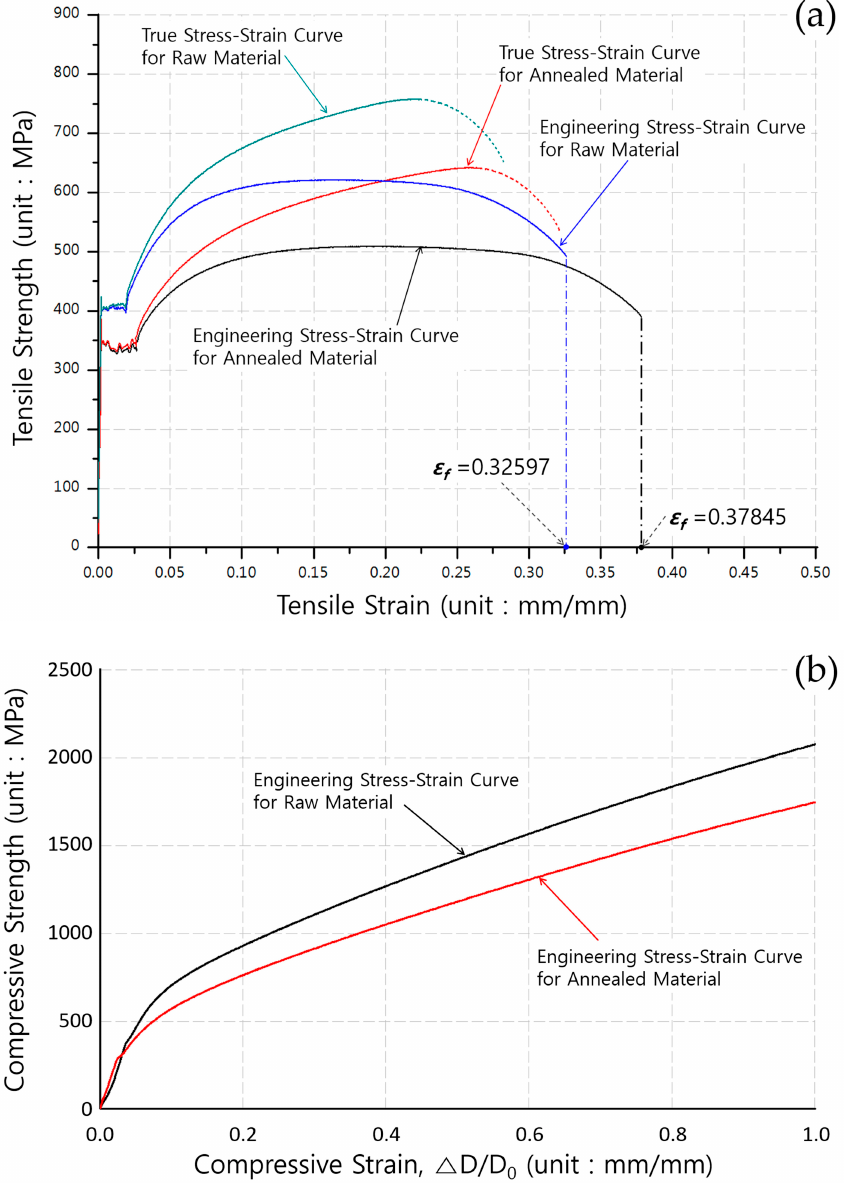
Figure 3. Stress–strain curves of AISI 1035 carbon steel before and after the spheroidizing heat treatment: ( a ) tensile stress–strain curves; ( b ) compressive stress–strain curves.